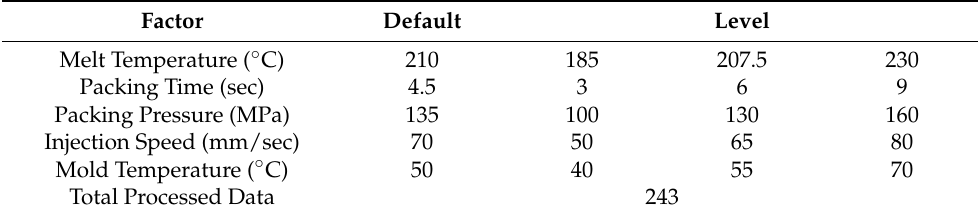
Table 1. Training data factors and level settings